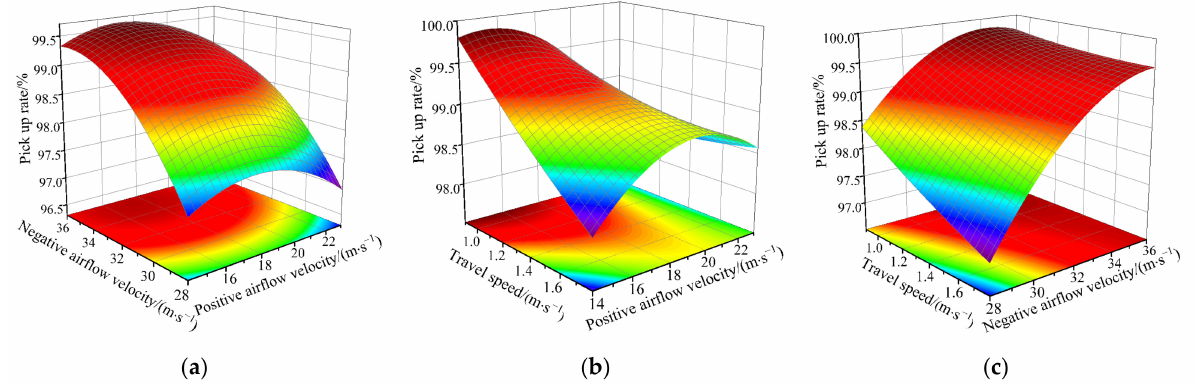
Figure 3. Response surfaces graph of the interaction factors for the pickup rate: ( a ) influence of interaction factors between the positive airflow velocity and the negative airflow velocity, ( b ) influence of interaction factors between the positive airflow velocity and the travel speed, and ( c ) influence of interaction factors between the negative airflow velocity and the travel